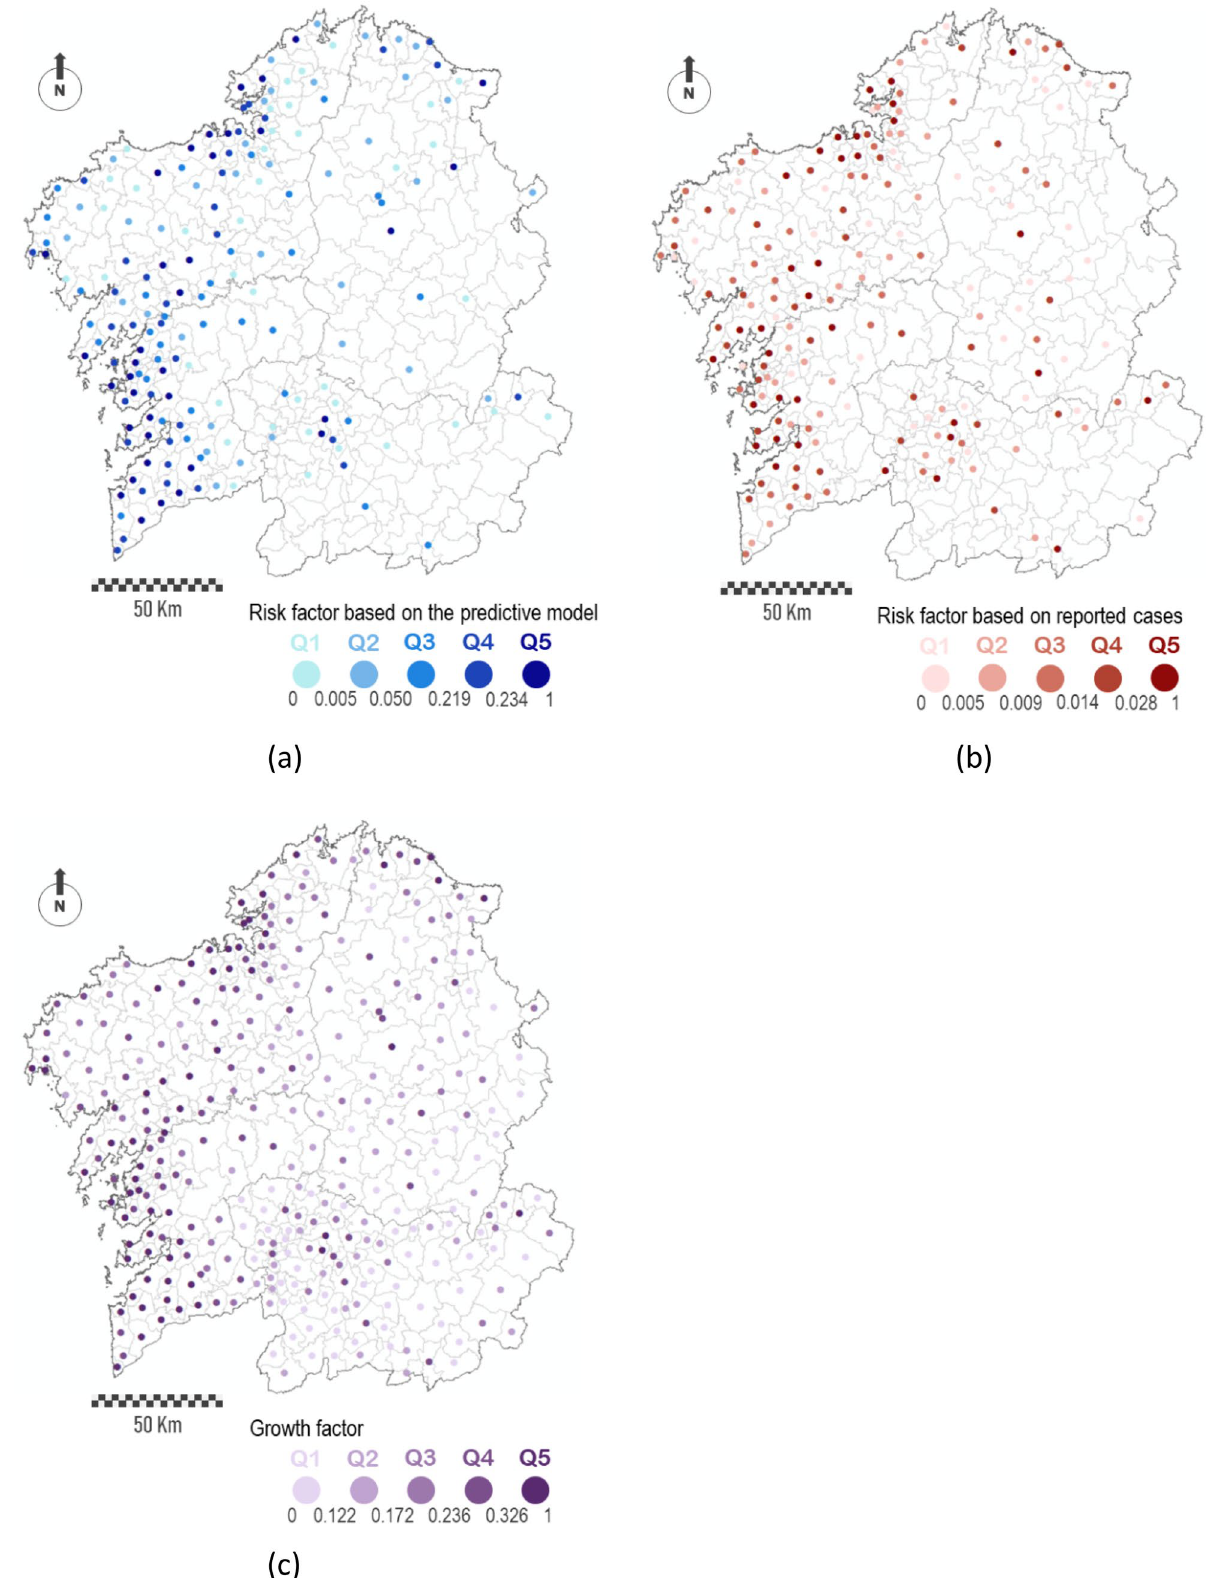
Figure 5. Spatial distribution of the risk factor ( a ), normalized cumulative incidence data ( b ), and growth factors ( c ) for each municipality. A value of 1 on the risk factor means that the node was found always among the top infected ones on each simulation. Following the same reasoning, a value of 0 means that that node was never found among the top ones. The ranking of the infective nodes was set with a total size of 30, and the cumulative incidence data was normalized over the highest value of reported cases. Maps are generated using ArcGIS Desktop software version 10.8 (from ESRI, https:// www. esri. com/ en- us/ arcgis/ produ cts/ arcgis- deskt op/ overv